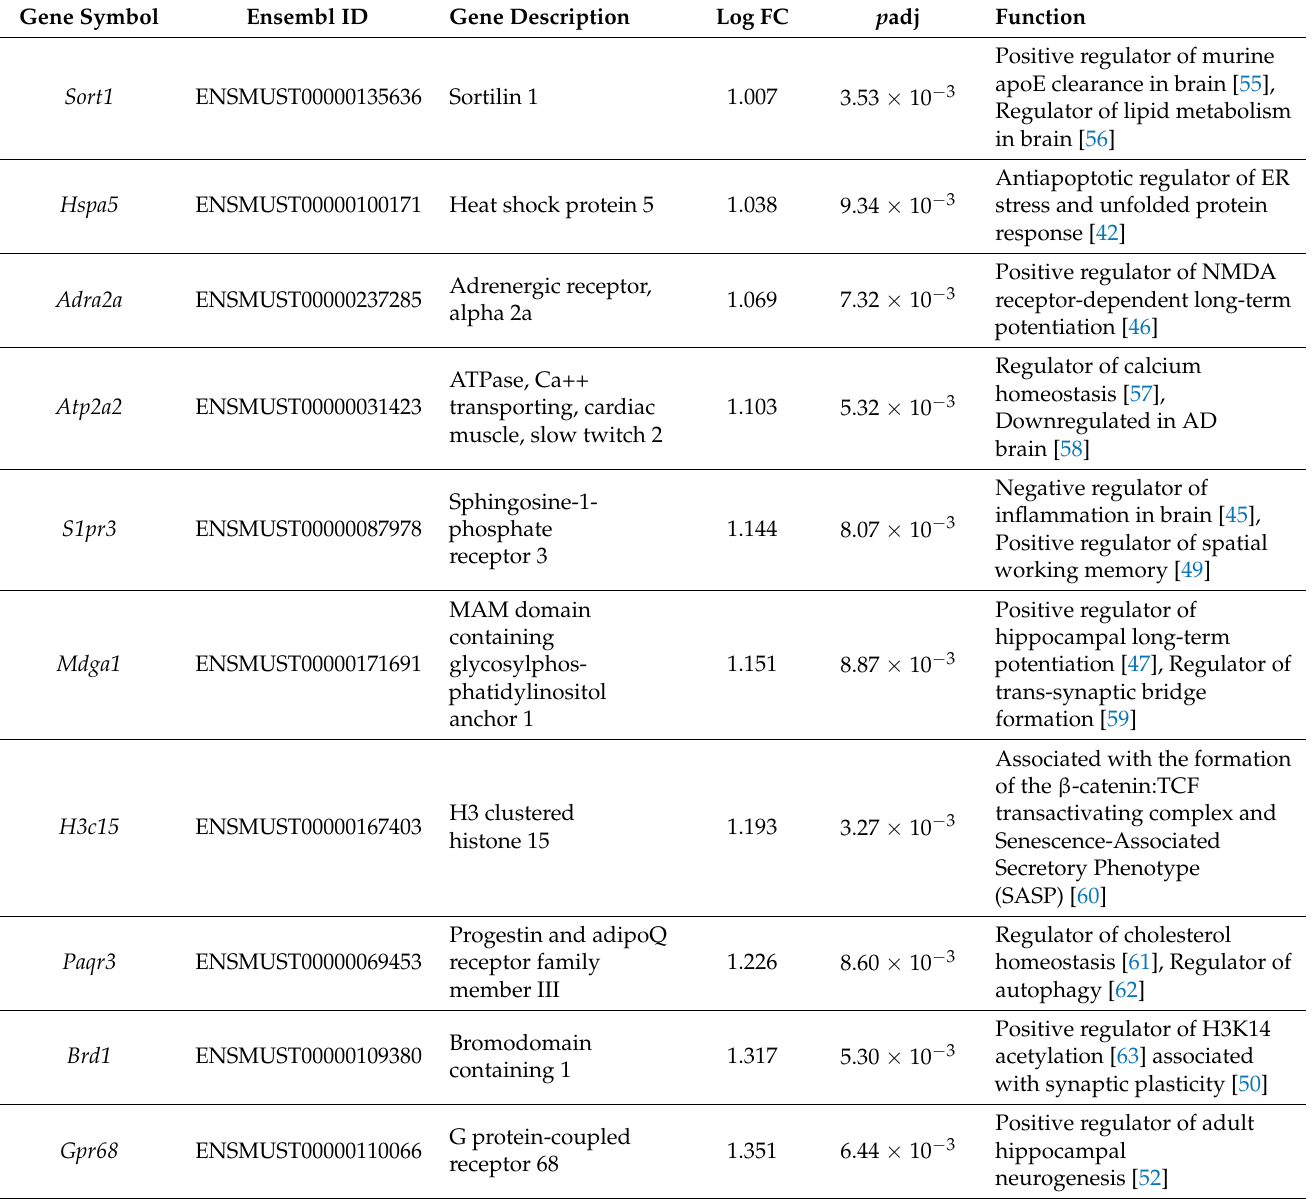
Table 2. Upregulated Transcripts in HFD-fed AKO Compared to HFD-fed WT Mice. Transcripts with LFC ≥ 1.00 and p adj ≤ 0.001 are displayed. Gene symbol, Ensembl ID, gene description, log fold change (log2), log10 adjusted p -value, and relevant known function are